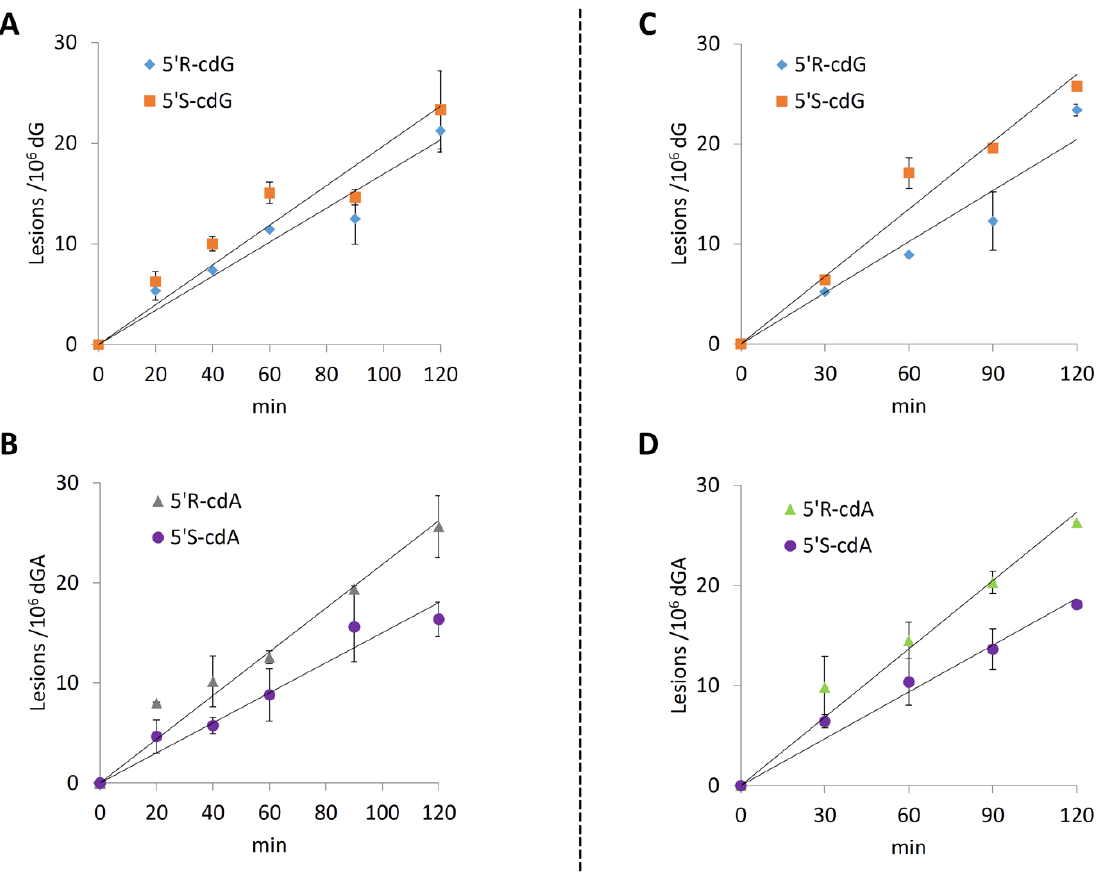
Figure 14. Kinetic study by Fenton reaction. (Left side): CuCl2/H2O2/Ascorbate-induced formation of 8-oxo-dG and 8-oxo-dA at 0, 20, 40, 60, 90 and 120 min. ds-(ODN5/ODN6) treated with CuCl 2 (15 µM), H 2 O 2 (120 µM); (Right side): Fe 2+ /H 2 O 2 /Ascorbate-induced formation of 8-oxo-dG and 8-oxo-dA at 0, 30, 60, 90 and 120 min. ds-(ODN5/ODN6) treated with Fe 2+ (15 µM), H 2 O 2 (120 µM), Ascorbate (1.2 mM). All points are the mean value (± standard deviation) of n = 2 independent experiments.